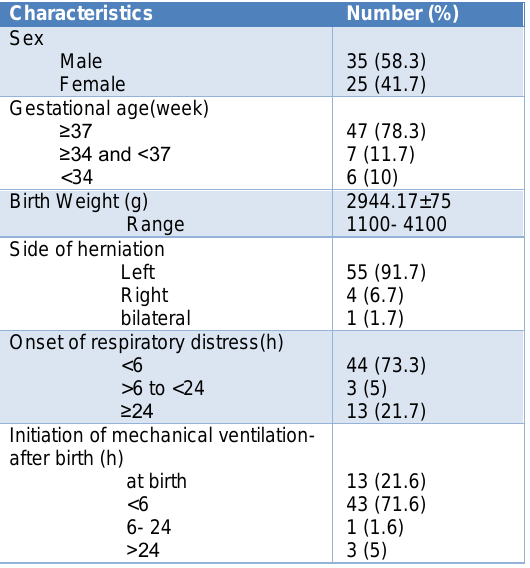
Table 1. Characteristics of neonates with CDH.